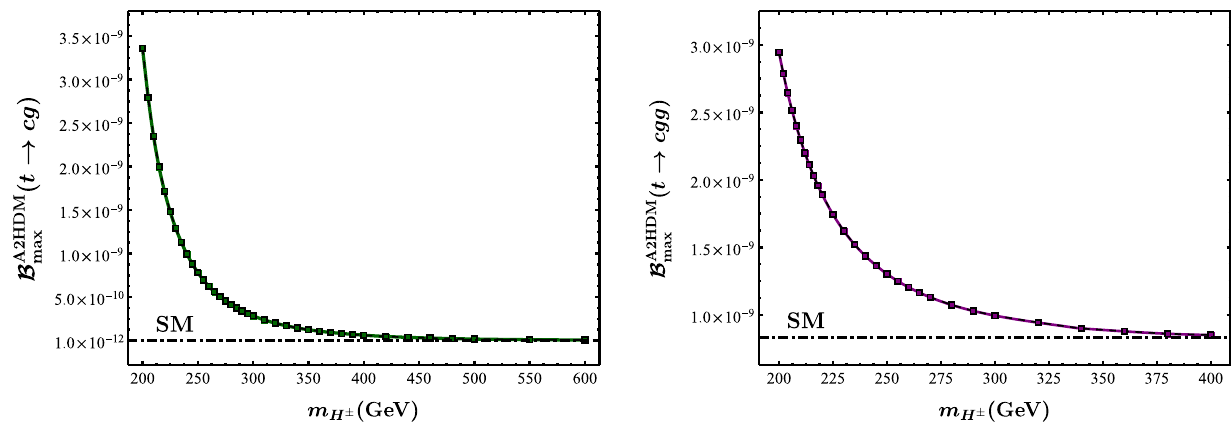
Fig. 5 The dependence of the maximum branching ratios of t → cg (left) and t → cgg (right) on the charged-Higgs mass m H ± , with the alignment parameters fixed at (ς u ,ς d ) (cid:8) ( − 0 . 047 , − 48 ) . The horizontal dash-dotted lines represent the SM predictions given by Eqs. (4.5) and (4.6),